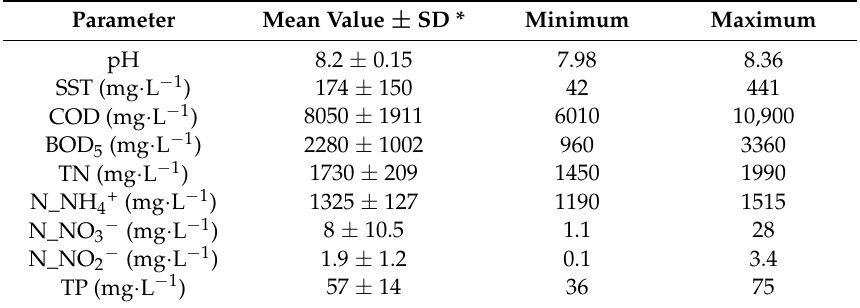
* Calculated from 1560 data